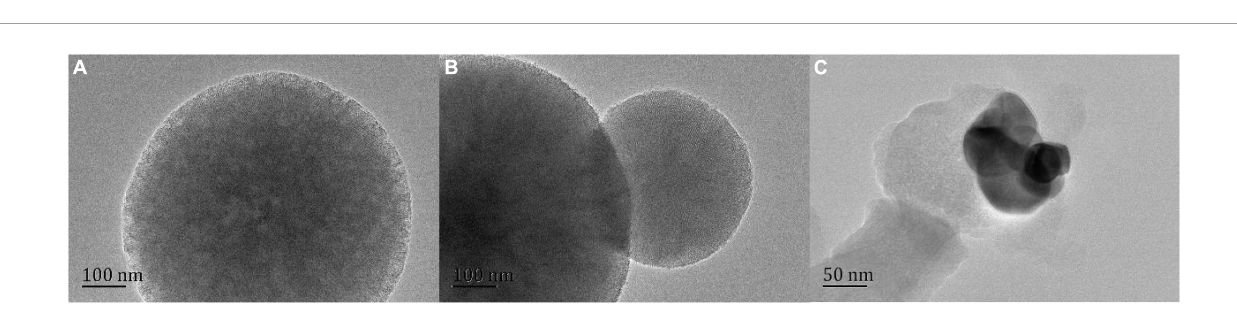
FIGURE5 Scanning electron microscope (SEM) images of MSN (A) and NG/MSN (B) , and KS-NM (C) .